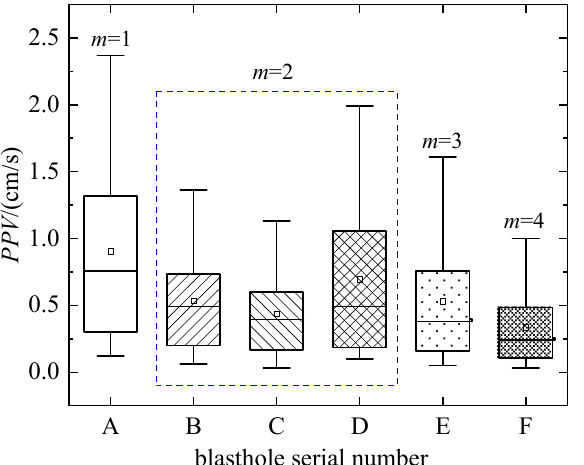
Figure 4. Diagram of variation in vibration velocity peak distribution with the serial number of blastholes.